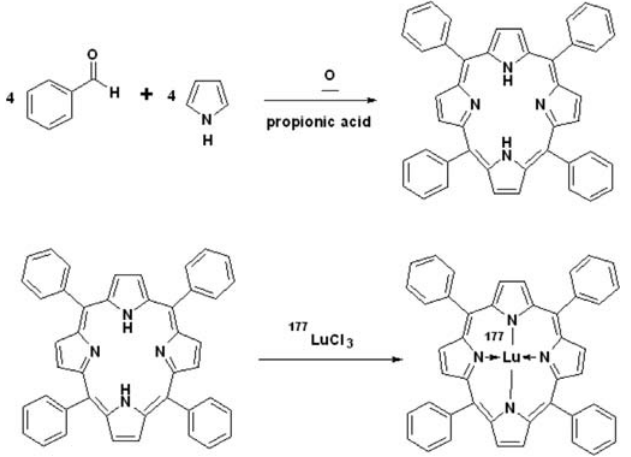
FIGURE 5 - Synthetic scheme for radiolabeling of TPP with 177 LuCl . 3